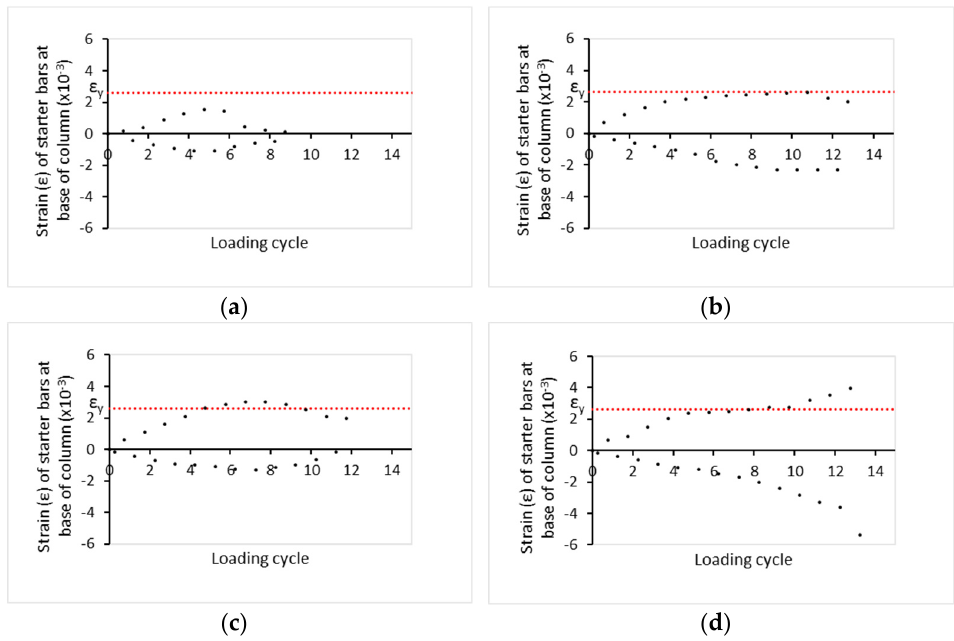
Figure 6. Peak pull and push steel strain of starter bars at the base of column ( a ) L20d_C, ( b ) L20d_R2, ( c ) L40d_C and ( d ) L40d_R2 at each loading cycle (based on results by [19]).